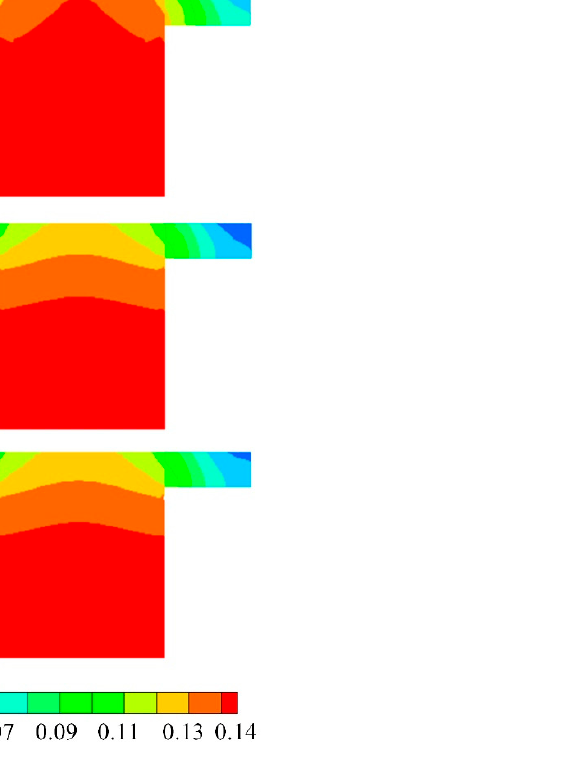
Figure 11. Distribution of oxygen mass fraction in the cathode channel cross sectional plane near the cathode inlet (z = 5 mm) when the operating voltage is 0.6 V in Case 2*, Case 3* and Case 4*.